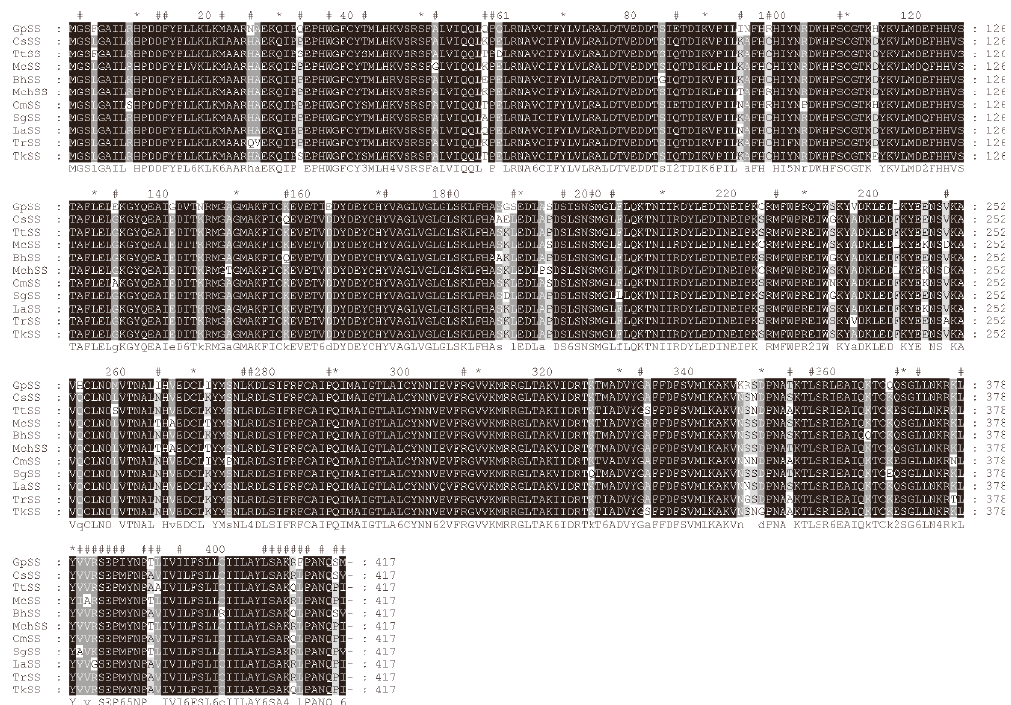
Figure 3: Multialignment of partial terrestrial plant SQS amino acid sequences. Sites of positive selection of SQS above 11 common medicinal Cucurbitaceae plants are shown through the Gendoc software, and GpSS was used as the reference sequence. Conserved sites are shaded, and the meaning of each symbol is given in the speci fi c symbol. # Positively selected site.